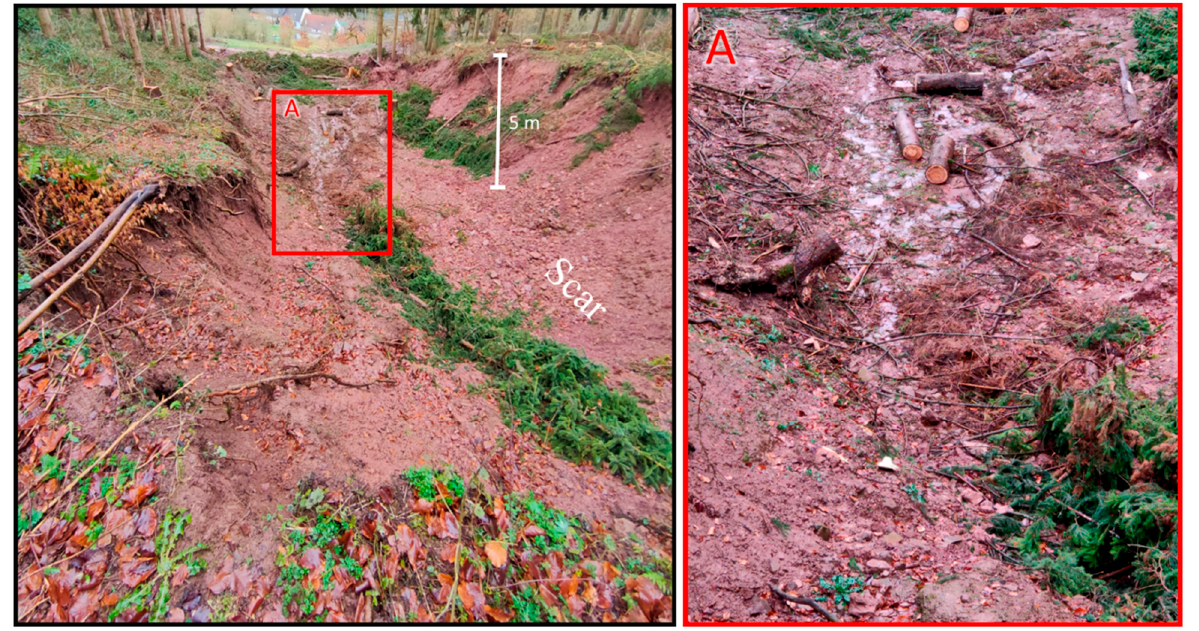
Figure 9. Spring water discharge in the scar of the hillslope debris flow at the depth and assumed location of the observed interflow lens.